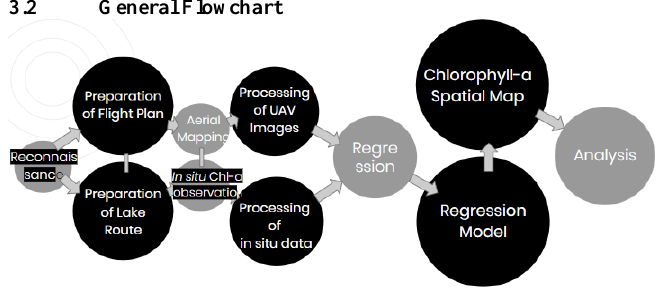
Figure 1. General Flowchart of the Research